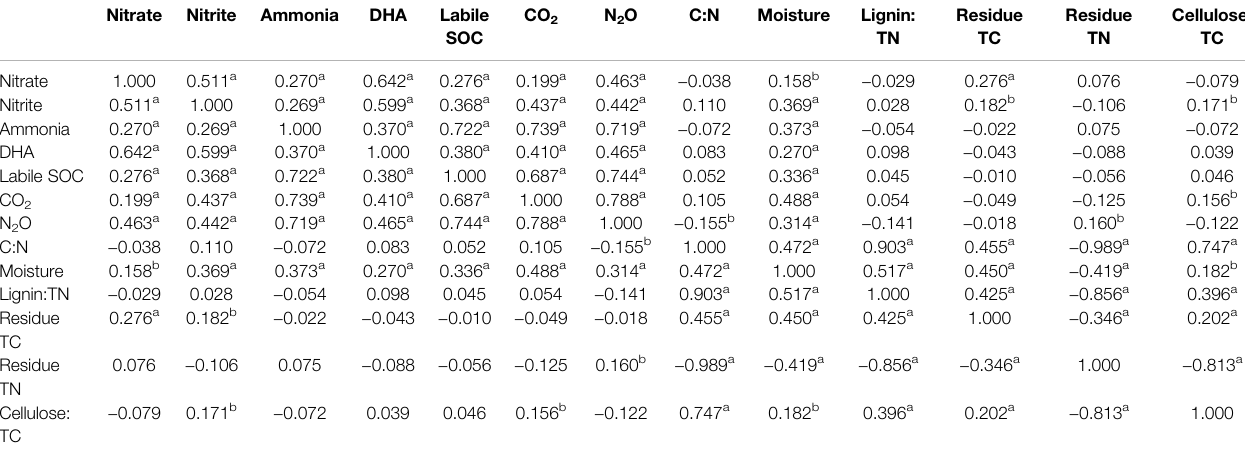
TABLE 7 | Pearson ’ s correlation coef fi cient between soil N 2 O emission and related soil and crop properties. Nitrate Nitrite